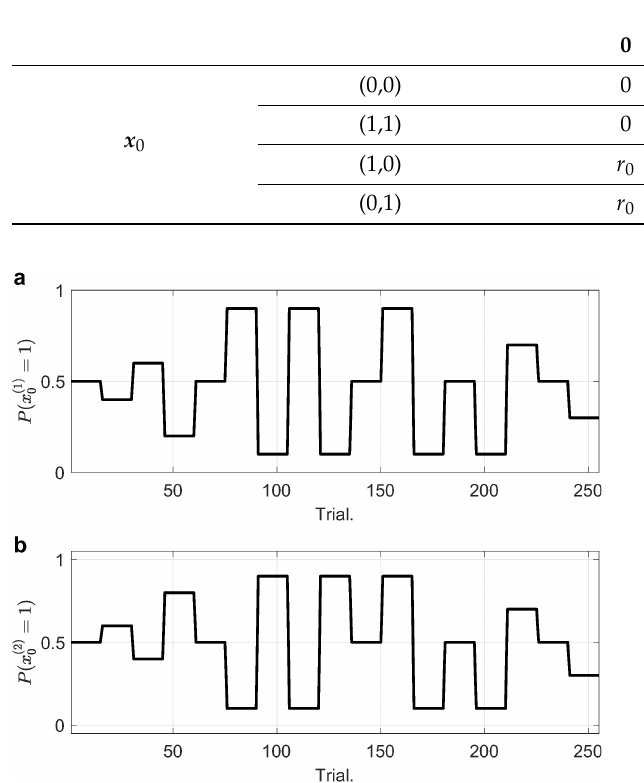
Figure 3. Expected states of the two-armed bandit. ( a ) Expected states of arm A. The mean of the state of arm A changes over time in a block fashion (black line). ( b ) Expected states of arm B. The mean of the state of arm B evolves over time (black line), showing variable correlations with that of arm A. By manipulating the expectations of the states of the two arms, we constructed a volatile environment. There were 17 blocks in the experiment. Each block consists of 15